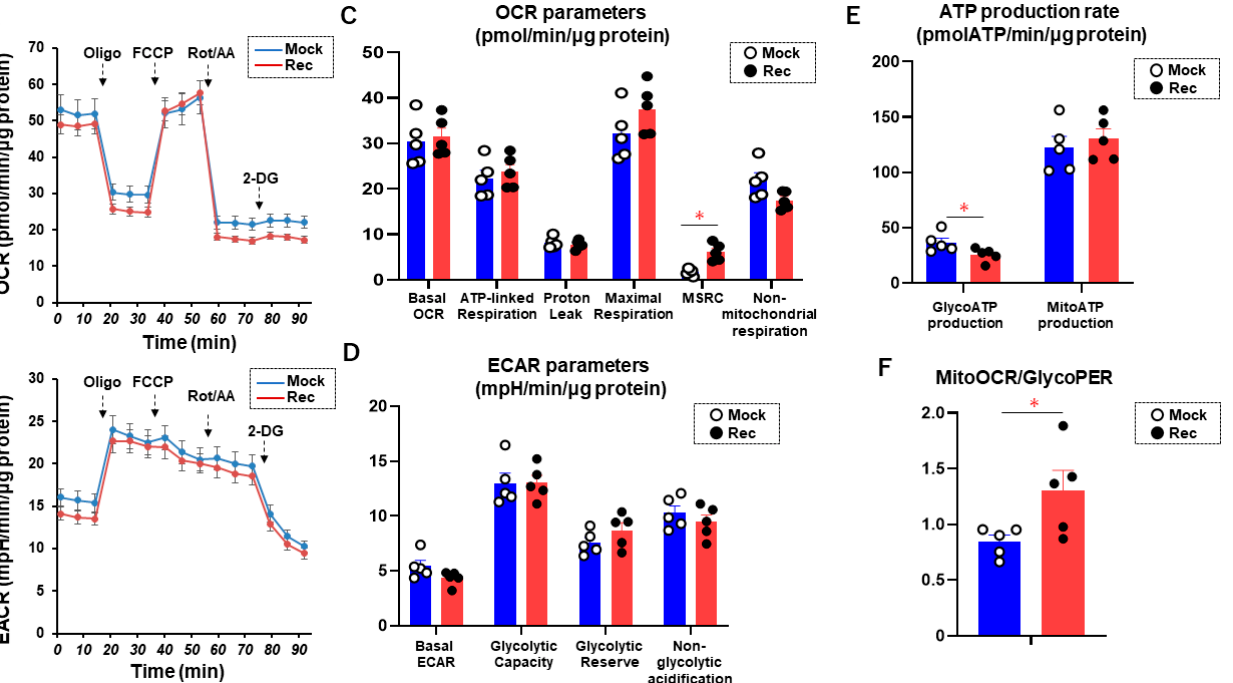
Figure 2. Measurement of mitochondrial and glycolytic functions of A549 MOCK and A549 Rec. The 2D-cultured A549 MOCK and A549 Rec cells were subjected to mitochondrial and glycolytic function analyses using a Seahorse XFe96 analyzer. Measurements of oxygen consumption rate (OCR, panel ( A )) and extracellular acidification rate (ECAR, panel ( B )) before drug injections (at baseline) and after subsequent supplementation with oligomycin (complex V inhibitor), FCCP (a protonphore), and rotenone/antimycin A (complex I/III inhibitors) and 2-DG (hexokinase inhibitor) are shown. Key parameters in mitochondrial respiration and glycolysis are shown in panel ( C ) and ( D ), respectively. MitoATP production rate and GlycoATP production rate are shown in panel ( E ). Basal mitoOCR/glycoPER ratio is shown in panel ( F ). Experiments were performed using fresh preparations (n = 5). Data are presented as the mean ± the standard error of the mean (SEM). * p < 0.05 (Student’s t -test).